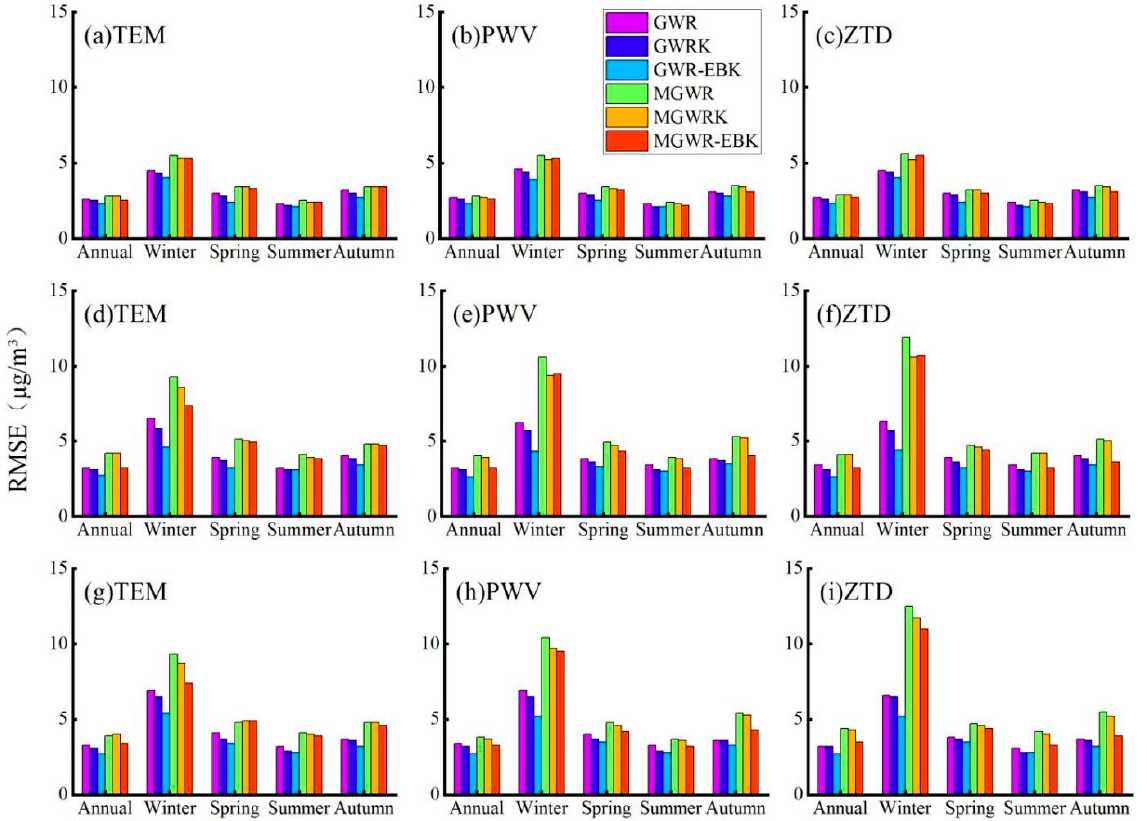
Figure 13. Model RMSEs for different elevation intervals: ( a – c ) ≤ 35 m, ( d – f ) 35–90 m, ( g – i ) ≥ 90 m.